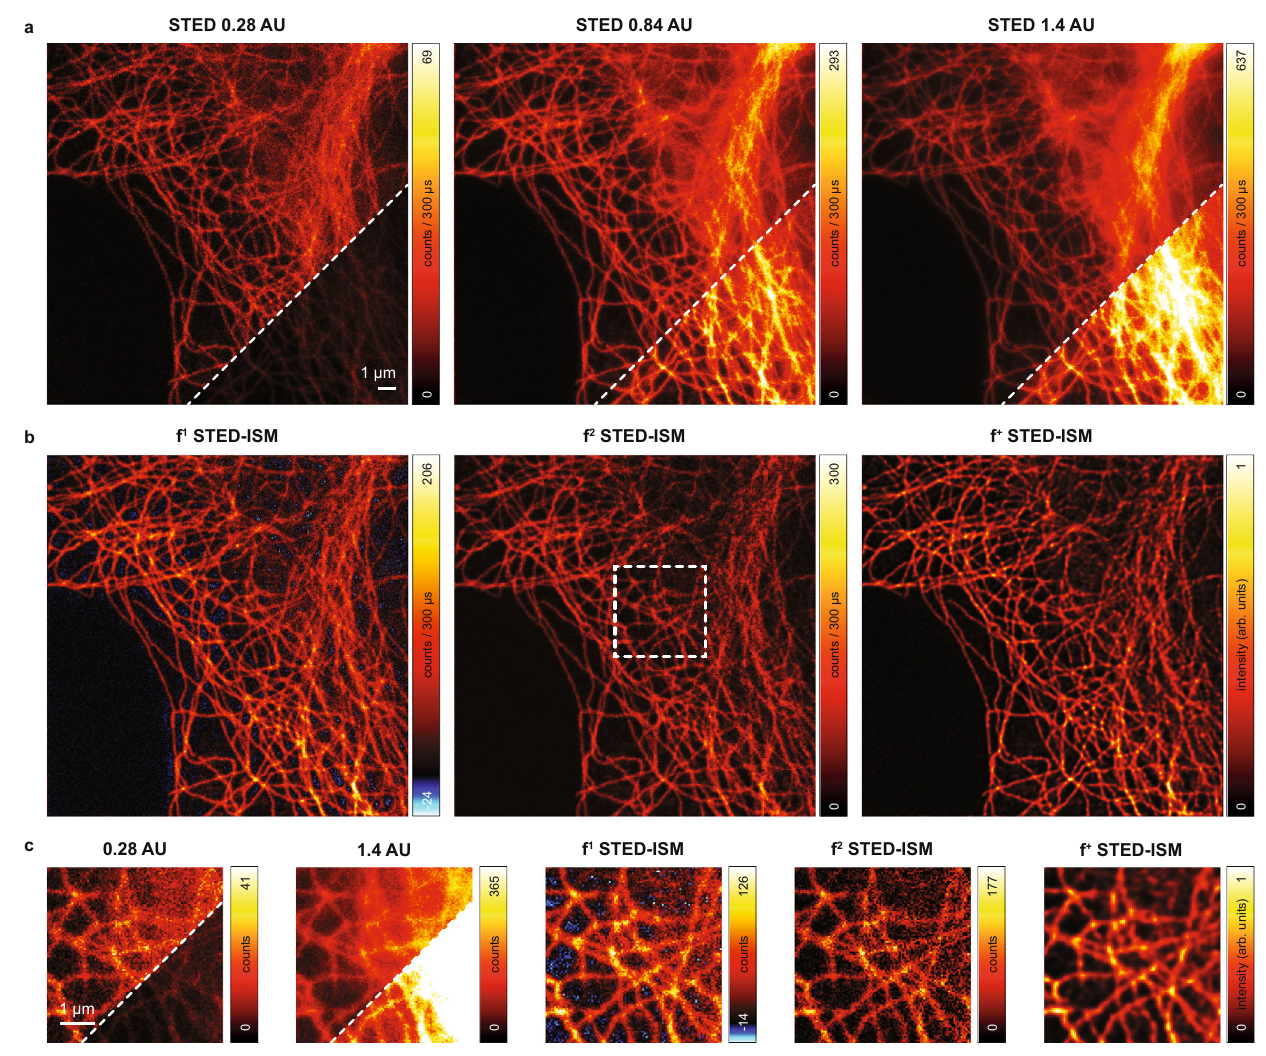
Fig. 5 | focus-ISM for STED imaging. a STED image of tubulin-labeled fi xed Hela cellatdifferentpinholesizes.Thebottom/rightcornerisnormalizedtothe f 2 -STED- ISM image. Even at the smallest pinhole size, the out-of-focus light hides some structure. b f-ISM reconstruction of the STED image. The f 1 -ISM may introduce some negative values, here coloured blue. The f 2 -ISM method does not produce